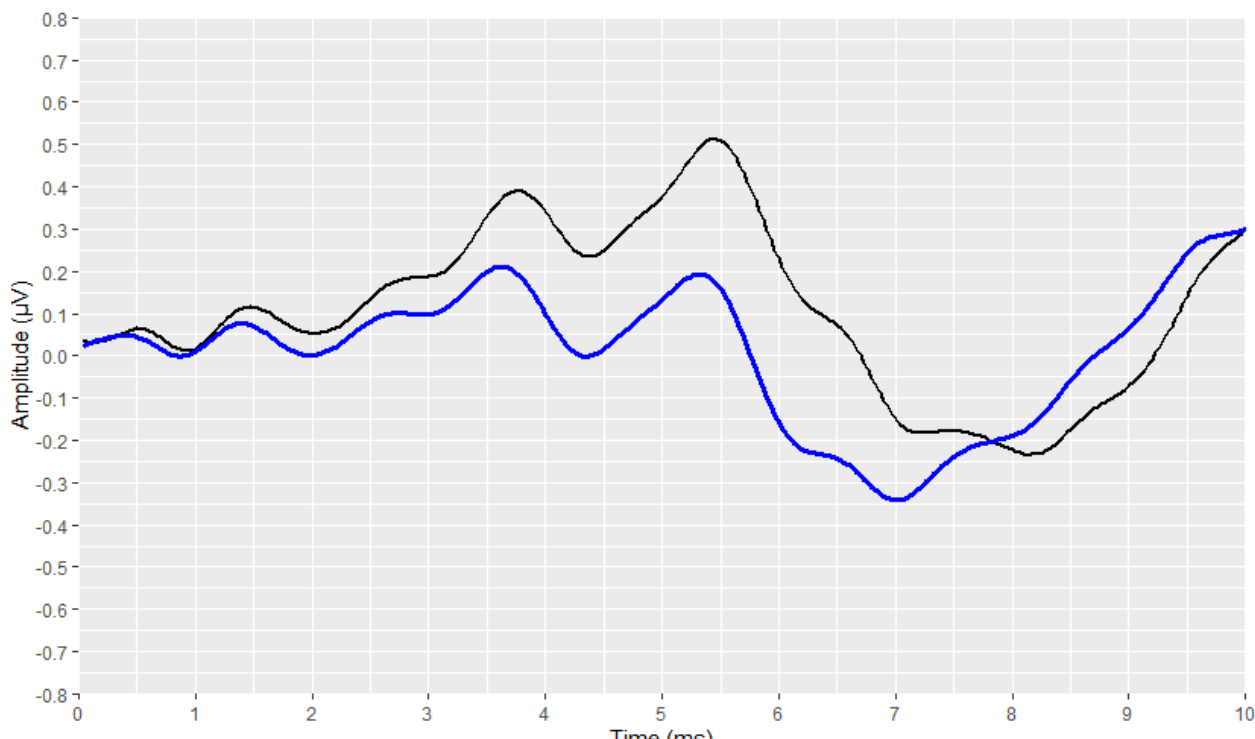
Figure 5. Visualization of an AMLR waveform after applying the visual display filters (raw signal is depicted in black and filtered signal is depicted in dark red).